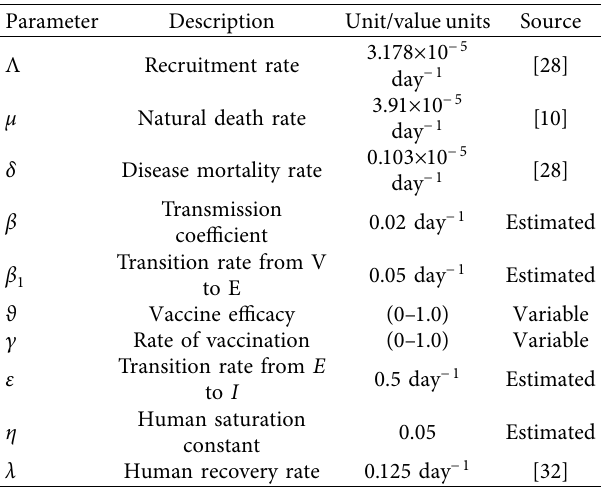
Table 2: The descriptive summary of the model